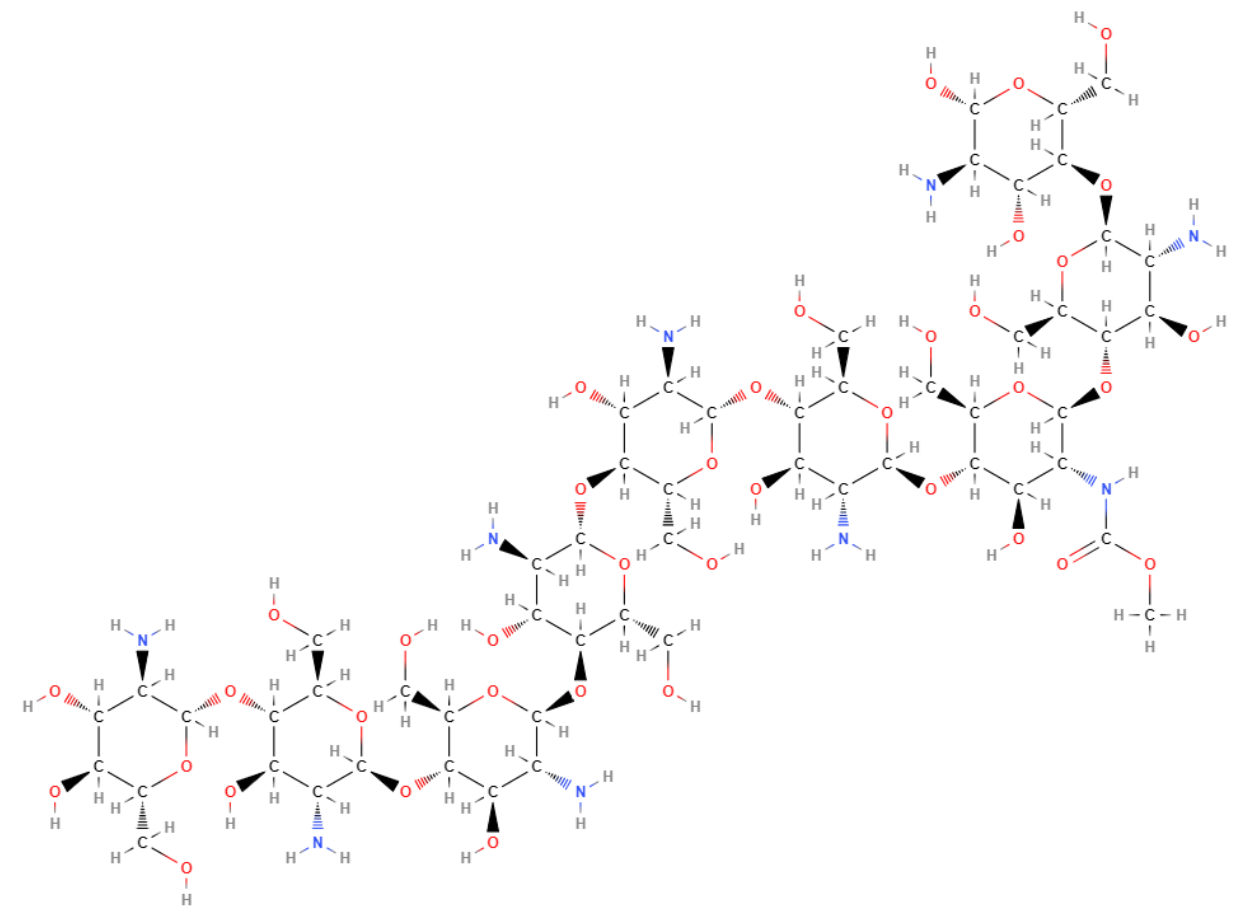
Figure 13. Representative structure of chitosan.